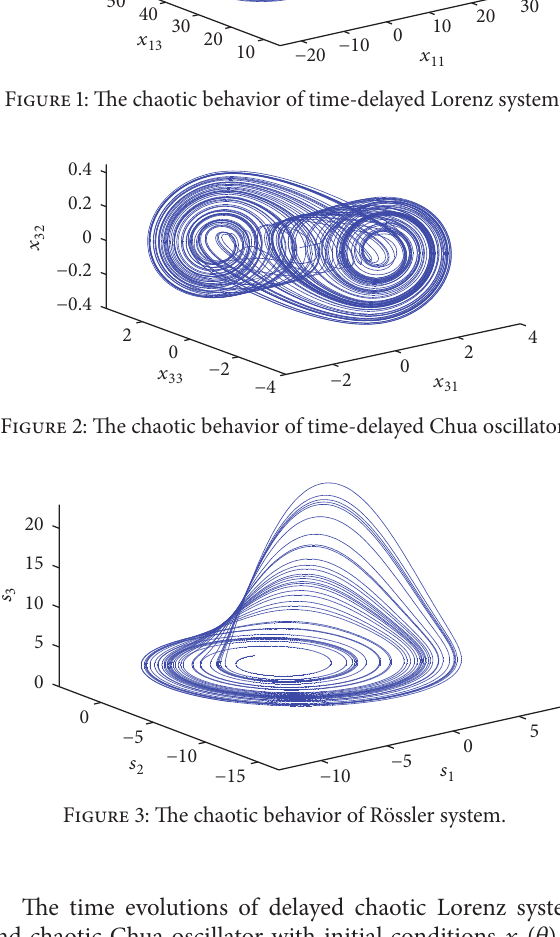
The time evolutions of delayed chaotic Lorenz system and chaotic Chua oscillator with initial conditions 𝑥 1 (𝜃) = [0, 1, 0] 𝑇 and 𝑥 (𝜃) = [0.7, 0, 0] 𝑇 for 𝜃 ∈ [−1, 0] are shown in 3 Figures 1 and